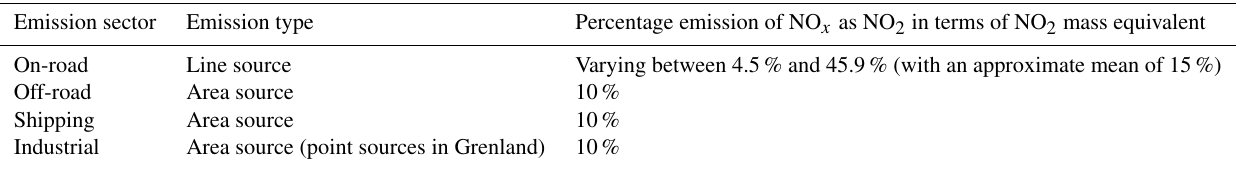
Table 5. A description of the emission type and the percentage emission of NO x as NO 2 (as NO2 mass equivalent) for each sector considered in the model simulation case studies.